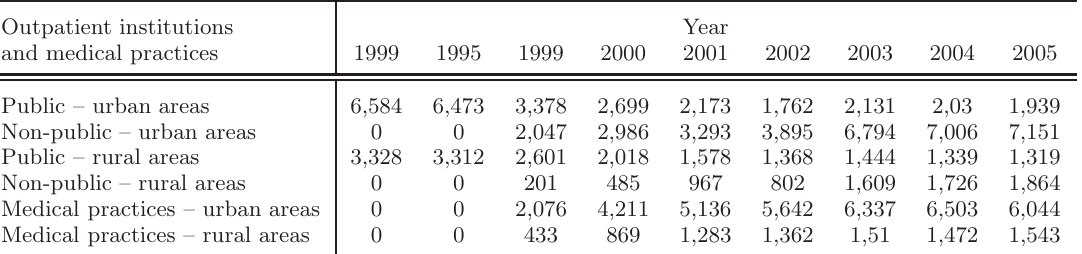
Table 1 Outpatient health care institutions and medical practices in